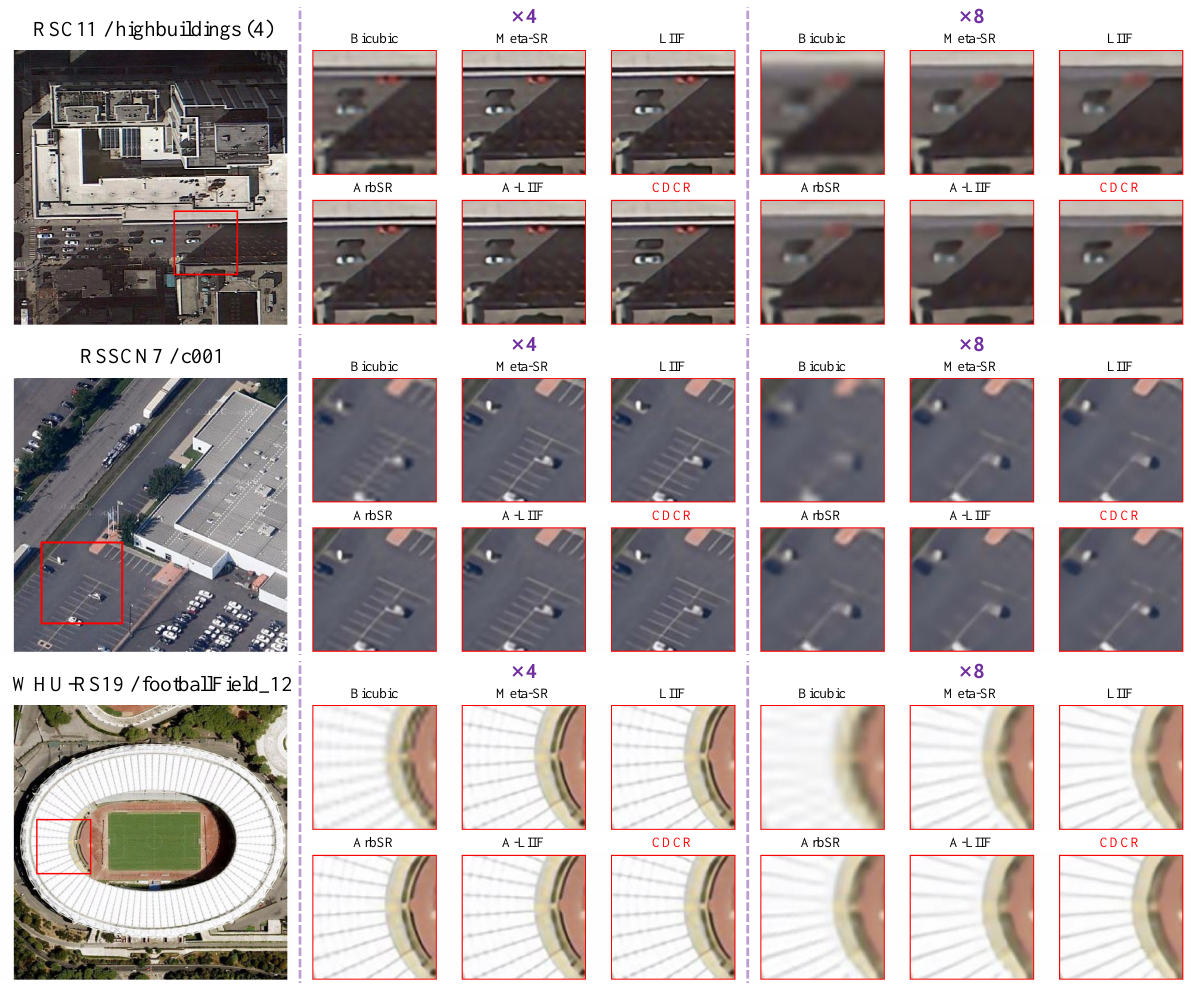
Figure 6. Visual comparison of the different methods at scale factors of 4 and 8.